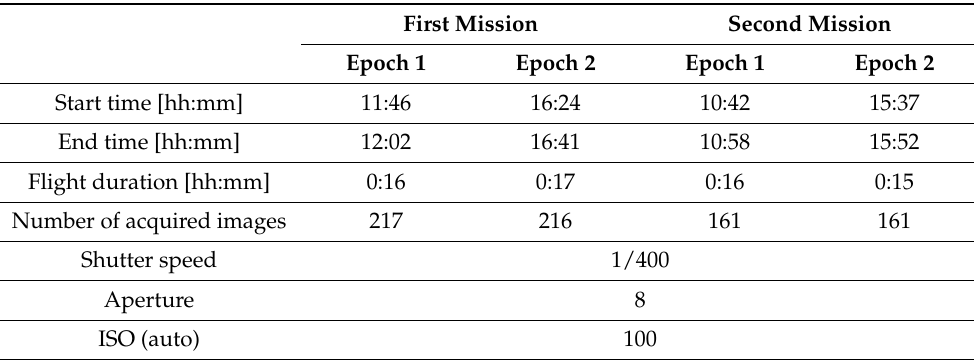
Table 2. Summary of UAS missions and camera